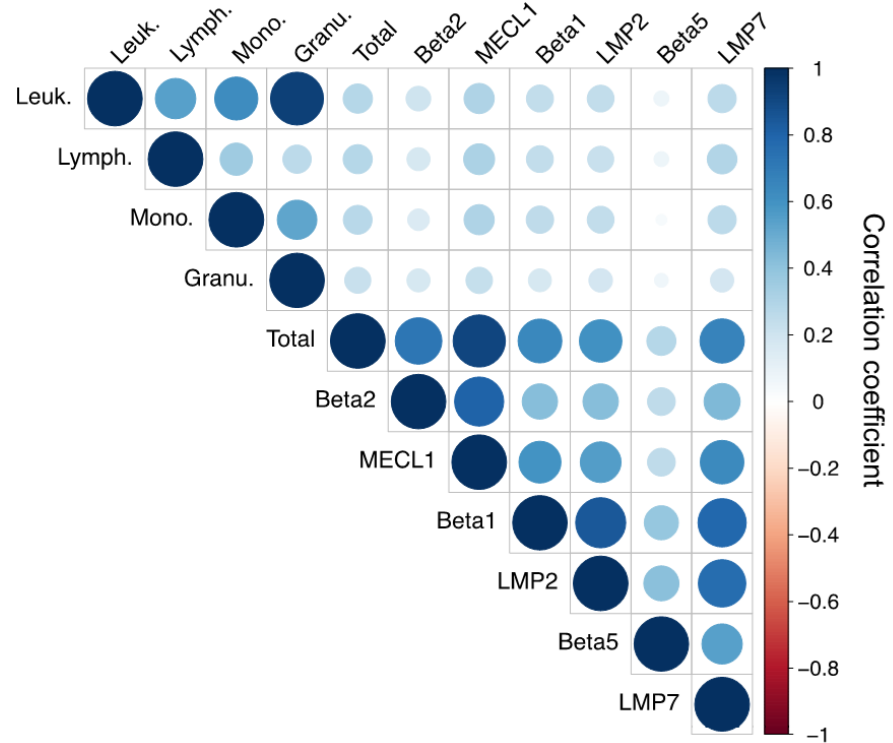
Figure 2. Correlation matrix of proteasome parameters and blood cell populations. Spearman’s rank correlation coefficients between standard and immunoproteasome activities with cell counts of leukocytes, lymphocytes, monocytes, and granulocytes are illustrated. Positive correlations are displayed in blue and negative correlations in red color. Color intensity and the size of the circle are proportional to the correlation coefficients.